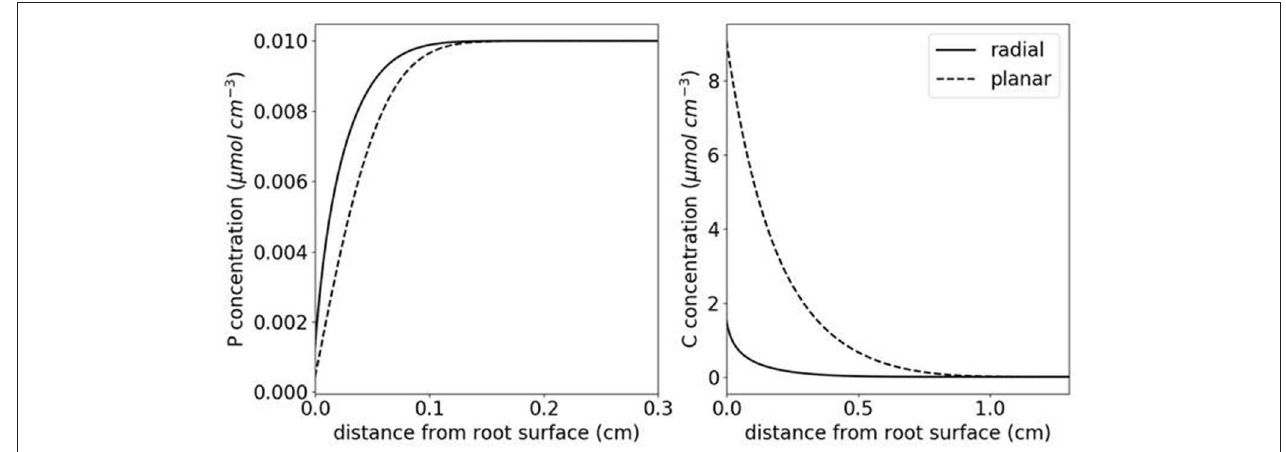
FIGURE 4 | Differences in the shape of spatial concentration profiles for P and citrate for radial vs. planar geometry. In order to simulate either root P uptake or root citrate exudation, the 1D diffusion-reaction equation was solved in either planar or radial coordinates while all other parameters stayed the same. The root radius in the radial case was taken to be 0.01cm. The domain was 5cm wide, i.e., not taking into account neighboring root effects, with zero-flux outer boundary condition. Sorption was described by a Langmuir isotherm (maximal sorption capacity; affinity constant: 500 and 15 cm 3 µ mol − 1 ; 2 and 1.5 cm 3 µ mol − 1 for P and citrate, respectively), P uptake was described by Michaelis Menten kinetics (maximal influx; Michaelis Menten constant: 2.72 × 10 − 6 µ mol cm − 2 s − 1 ; 7.17 × 10 − 3 µ mol cm − 3 ), citrate exudation was described by a constant rate of 3.00 × 10 − 6 µ mol cm − 2 s − 1 , the effective diffusion coefficient D e in porous medium was taken to be D e = D